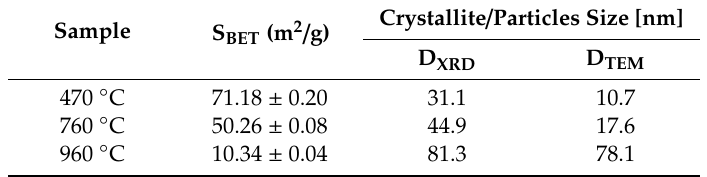
Table 1. BET surface area and the average crystallite / particle size of CA powders.